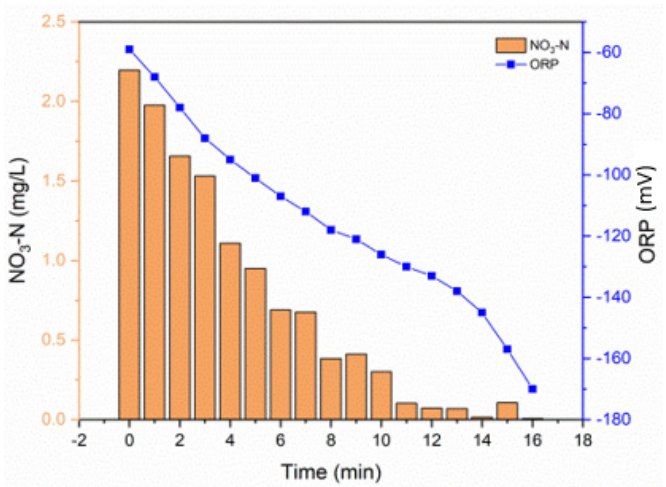
Figure 6. Variation trends of the nitrate concentration and ORP value. The histogram represents the nitrate concentration, and the blue curve represents the ORP value change.